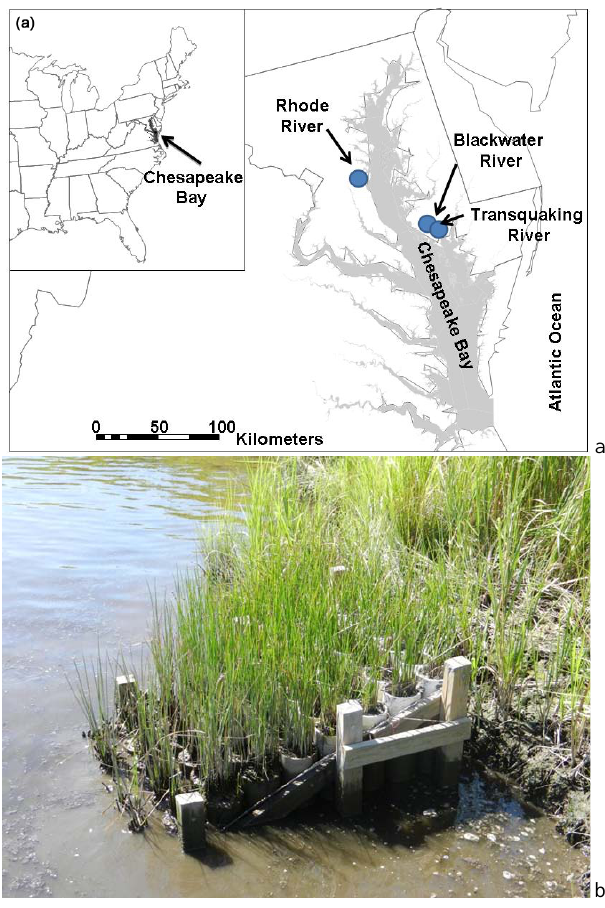
Fig. 1. Map of experiment locations (a) and photograph of experi- mental elevation platform at low tide in a tributary tidal creek of the Transquaking River (b)